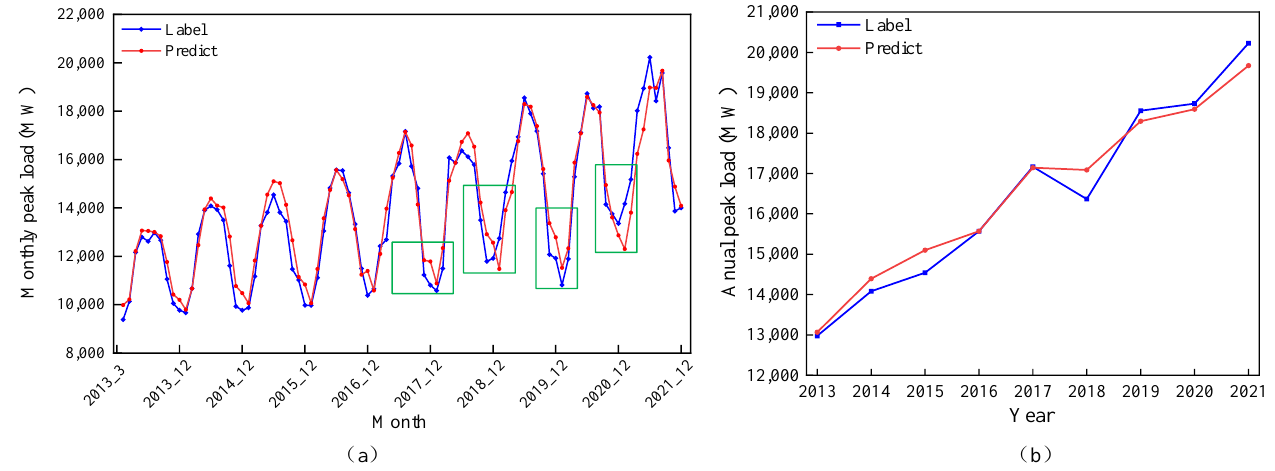
Figure 10. Forecast results in Case 1: ( a ) monthly peak load from March to December (2013 – 2021); ( b ) annual peak load from 2013 to 2021. Table 4. Predictive performance of the proposed model with various time-series lengths.